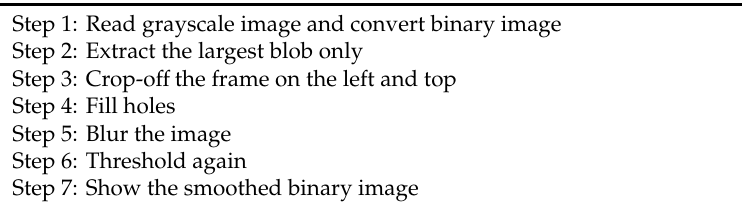
Table 4. Processing steps of edges smoothing method.